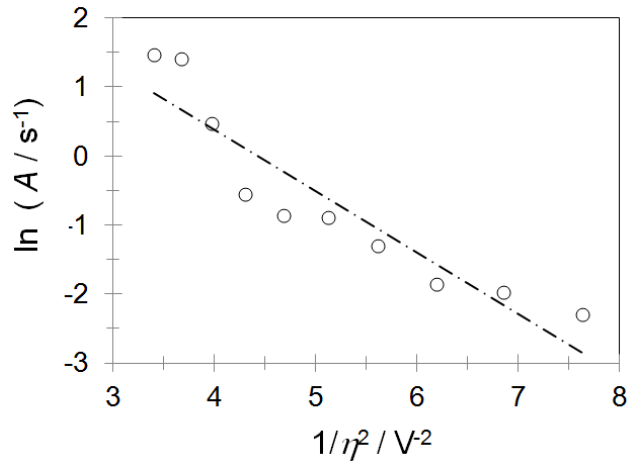
Figure 8. ln A vs . η -2 plot used to calculate the Gibbs nucleation energy according to Eq. 15 . The broken straight line corresponds to the linear fit to the experimental data.